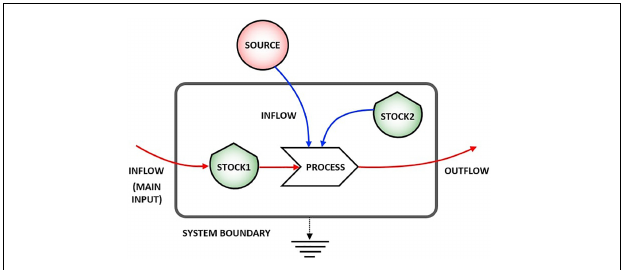
FIGURE 1 | Representation of a stock-flow system. Stock 1 undergoes a process due to the action of both Stock 2 and an external source.